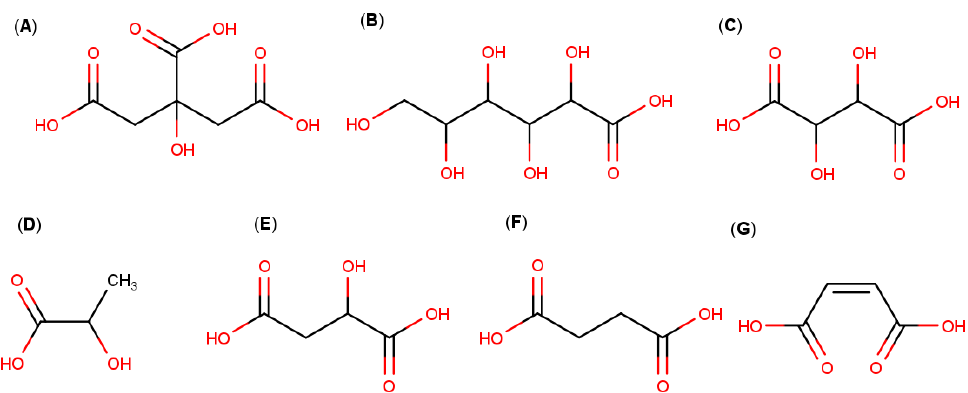
Figure 4. Molecular structures of: ( A ) citric acid, ( B ) gluconic acid, ( C ) tartaric acid, ( D ) lactic acid, ( E ) malic acid, ( F ) succinic acid and ( G ) maleic acid.